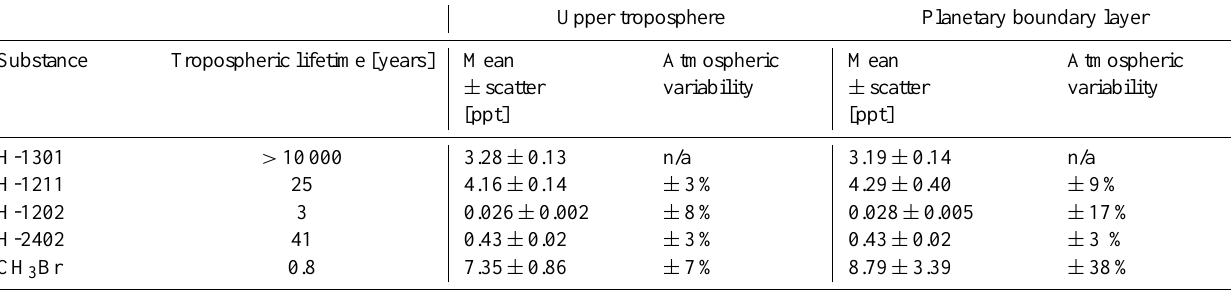
Table 5. Overview over the mean mixing ratios of the long-lived halons and CH 3 Br in the upper troposphere and the PBL as observed during SHIVA. The scatter is the absolute standard deviation of all measurements around the given mean value. The atmospheric variability is calculated as given in Eq. (3). For H-1301, no meaningful variability can be calculated (noted by n/a), as the scatter of the atmospheric measurements is smaller than the measurement precision of the instrument during the flight (see Sect. 2.2). Lifetimes for the halons are adapted from Newland et al. (2013) and the lifetime of CH 3 Br is taken from Montzka and Reimann et al. (2011). Upper troposphere Planetary boundary layer